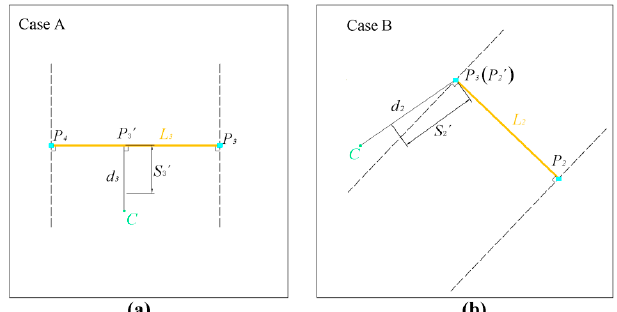
Figure 5. Relative position of the incenter of the extraction element and mining boundary lines: ( a ) the incenter of the extraction element located between two endpoints of a mining boundary line; ( b ) the incenter of the extraction element located out of two endpoints of a mining boundary line.